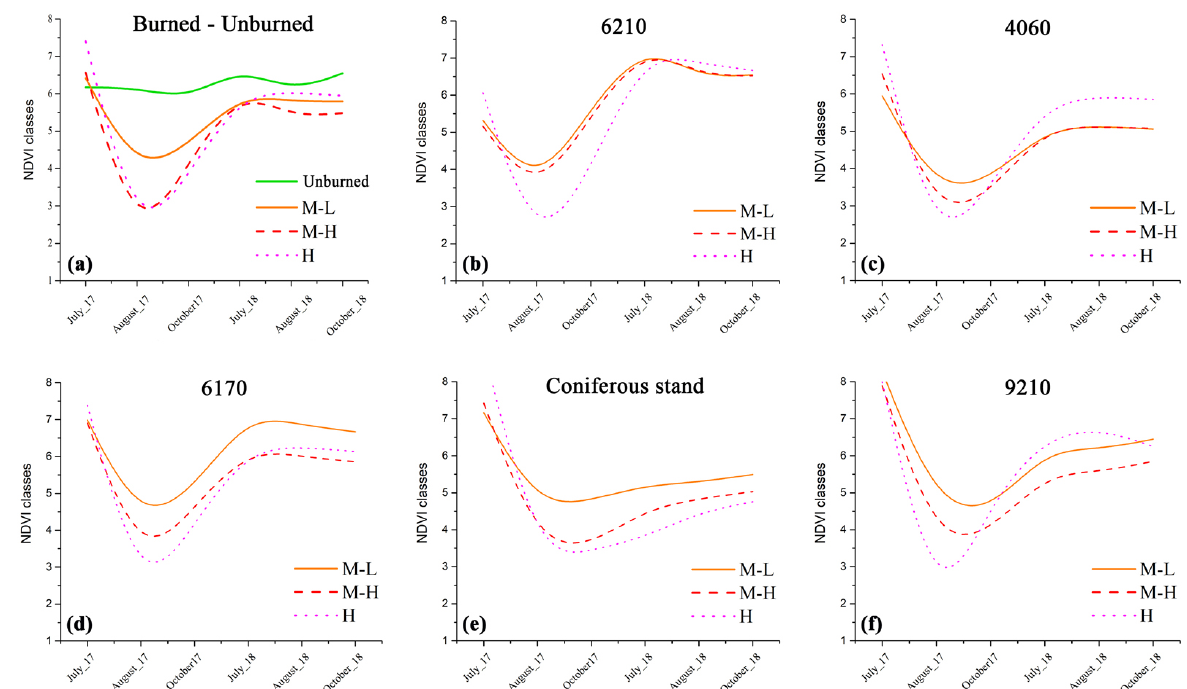
Figure 6. NDVI trends of the total burned and unburned area, and within ‘burn severity’ classes, in the threatened habitats. ‘Burn severity’ classes: M-L = Moderate-Low Severity (orange solid line); M-H = Moderate-High Severity (red dash line); H = High Sever- ity (violet dotted line). (a) NDVI average trends of unburned areas in a 500 meters buffer around the burned scar (green solid line), and ‘burn severity’ classes (M-L, M-H, H) for the total threatened area. The other graphs represent the NDVI average trends within the ‘burn severity’ classes for different Annex I habitats plus coniferous stands: (b) 6210* (Semi-natural dry grasslands and scru- bland facies on calcareous substrates), (c) 4060 (Alpine and boreal heaths), (d) 6170 (Alpine and subalpine calcareous grasslands), (e) coniferous stands, (f) 9210* (Apennine beech forests with Taxus and Ilex ). The habitats 6230* [Species-rich Nardus grasslands, on siliceous substrates in mountain areas (and sub-mountain areas, in Continental Europe)], 6430 (Hydrophilous tall herb fringe communities of plains and of the montane to alpine levels) and 8210 (Calcareous rocky slopes with chasmophytic vegetation) are not included because of the limited extent of their